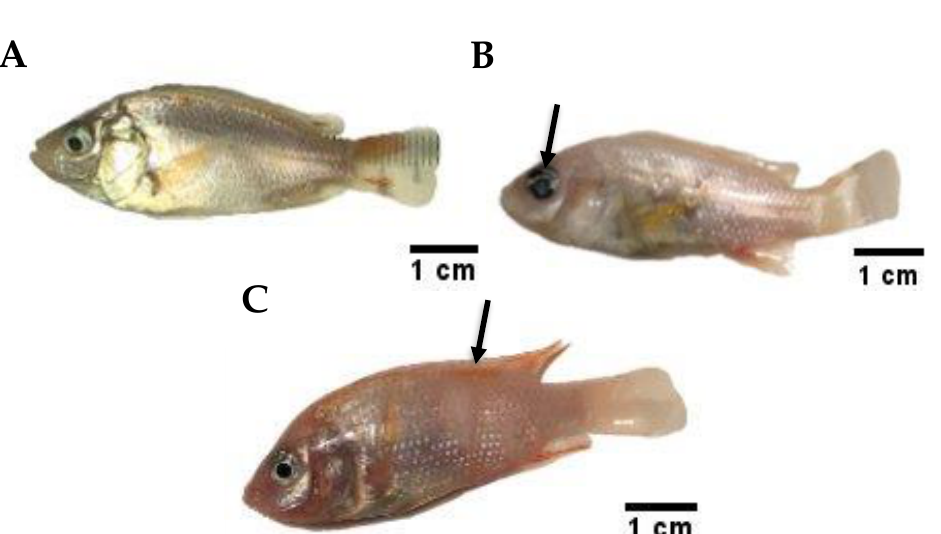
Figure 3. Clinical observation of red hybrid tilapia after challenge with Streptococcus agalactiae . A healthy fish in the control ( A ) and infected fish ( B , C ). Challenged fish showed eye opacity, redness ( B ) and lesions on the body ( C ) post-infection.